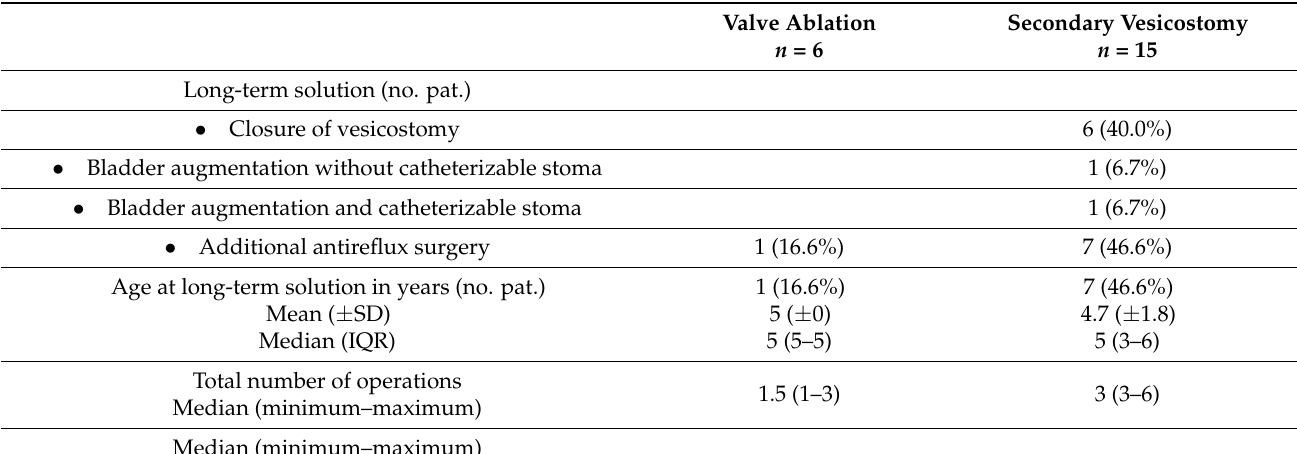
Table 6. Follow-up in terms of operative management.